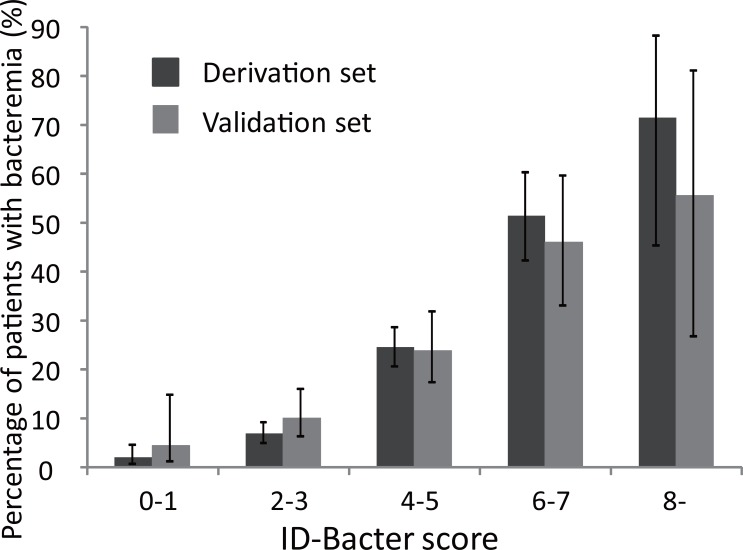
Percentages of patients with true bacteremia, by ID-BactER score.Fig 2 shows, for each of five categories defined by ID-BactER score, the percentage of patients in that category who had true bacteremia.